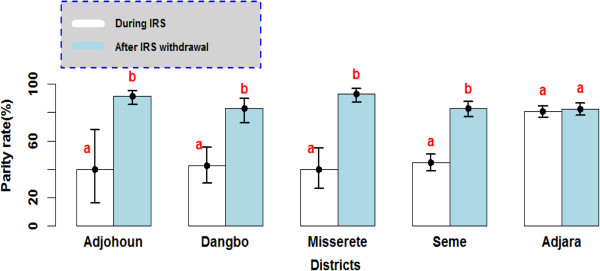
Parity rate of Anopheles gambiae observed during the implementation of IRS and after IRS withdrawal. The rate carrying the same letter per district was not significantly different (p> 0.05).